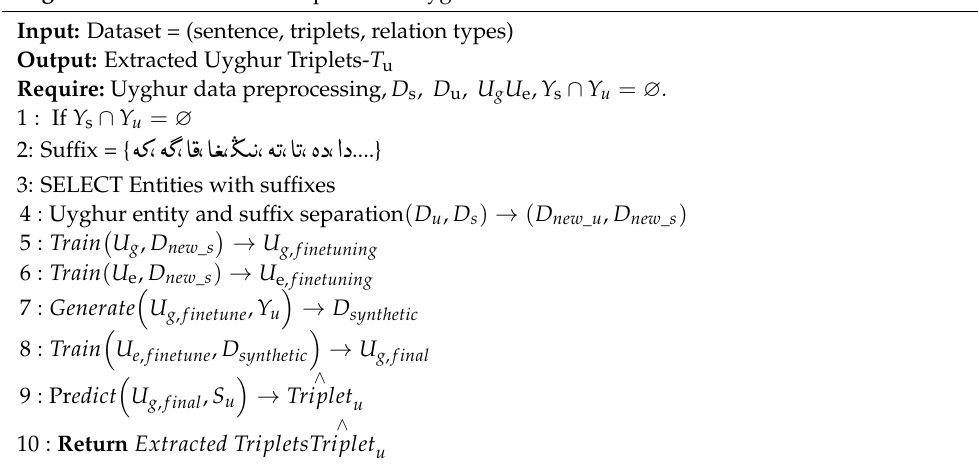
Algorithm 1: Zero-Shot-Prompt-RE for